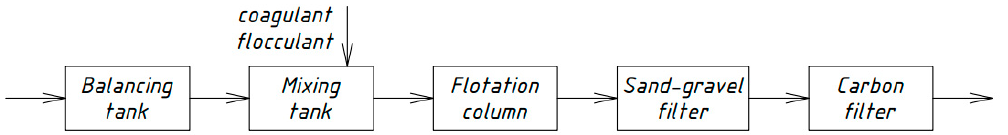
Figure 4. Wastewater treatment scheme with a flotation column .